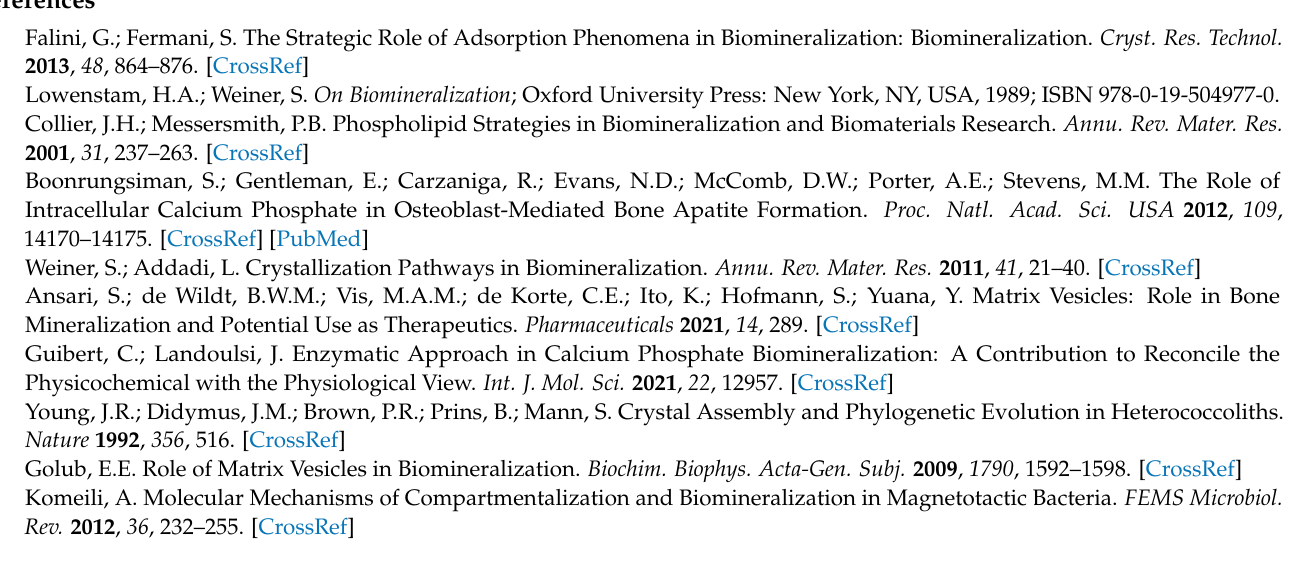
Figure S5. TEM micrographs and size distribution of ACP particles formed in control system and in the presence of DMPC and DMPS liposomes in spontaneous precipitation experiment. Figure S6. Representative pH vs. time curve of CaCO 3 spontaneous precipitation experiments. Figure S7. PXRD patterns of the precipitate formed after 60 min reaction time in CaCO 3 spontaneous precipitation experiments. Table S1. Assignment of IR bands in the FTIR spectra of 1,2-dimyristoyl-sn-glycero-3- phosphocholine (DMPC). Table S2. Assignment of IR bands in the FTIR spectra of 1,2-dimyristoyl- sn-glycero-3-phospho-L-serine (DMPS). Table S3. Assignment of IR bands in the FTIR spectra of 11,2-dioleoyl-sn-glycero-3-ethylphosphocholine (EPC). Table S4. Hydrodynamic diameter ( d h ) and zeta potential ( ζ ) of liposomes. Table S5. Assignment of IR bands in the FTIR spectra of precipitate formed after 60 min in calcium phosphate control system. Table S6. Assignment of IR bands in the FTIR spectra of precipitate formed after 60 min in calcium phosphate system containing DMPC liposomes. Table S7. Assignment of IR bands in the FTIR spectra of precipitate formed after 60 min in calcium phosphate system containing DMPS liposomes. Table S8. Assignment of IR bands in the FTIR spectra of precipitate formed after 60 min in calcium phosphate system containing EPC liposomes. Table S9. Assignment of IR bands in the FTIR spectra of precipitate formed after 60 min in calcium carbonate control system. Table S10. Assignment of IR bands in the FTIR spectra of precipitate formed in calcium carbonate system containing DMPC liposomes. Table S11. Assignment of IR bands in the FTIR spectra of precipitate formed in calcium carbonate system containing DMPS liposomes. Table S12. Assignment of IR bands in the FTIR spectra of precipitate formed in calcium carbonate system containing EPC